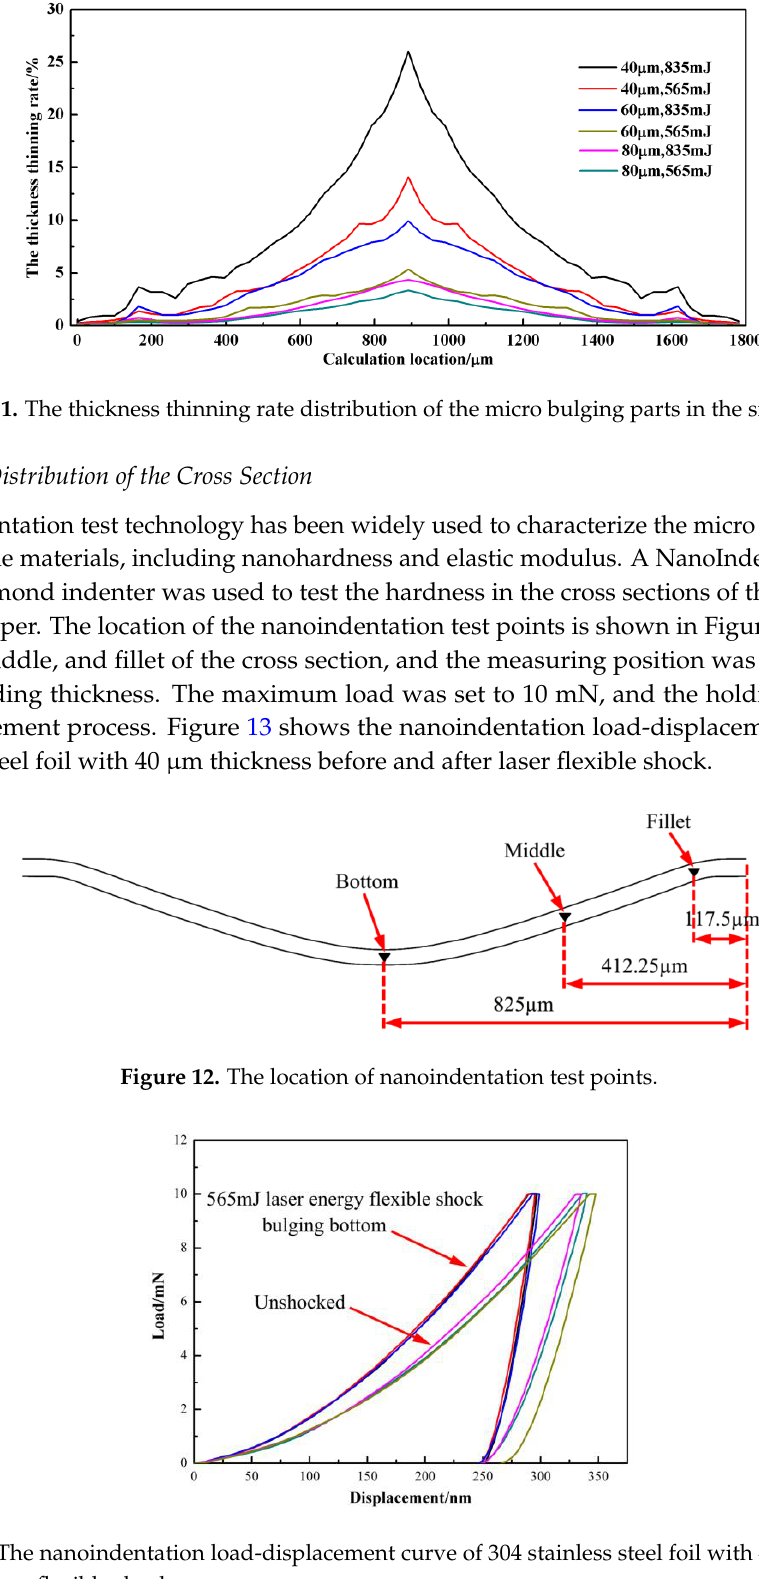
Figure 11. The thickness thinning rate distribution of the micro bulging parts in the simulation.